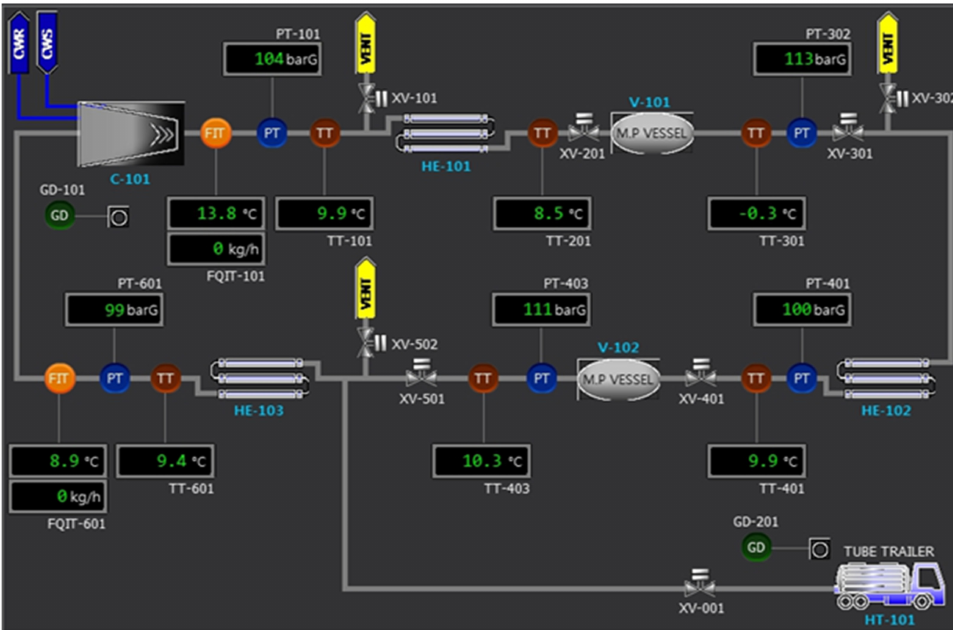
Figure 2. The hydrogen-storage cycle system.